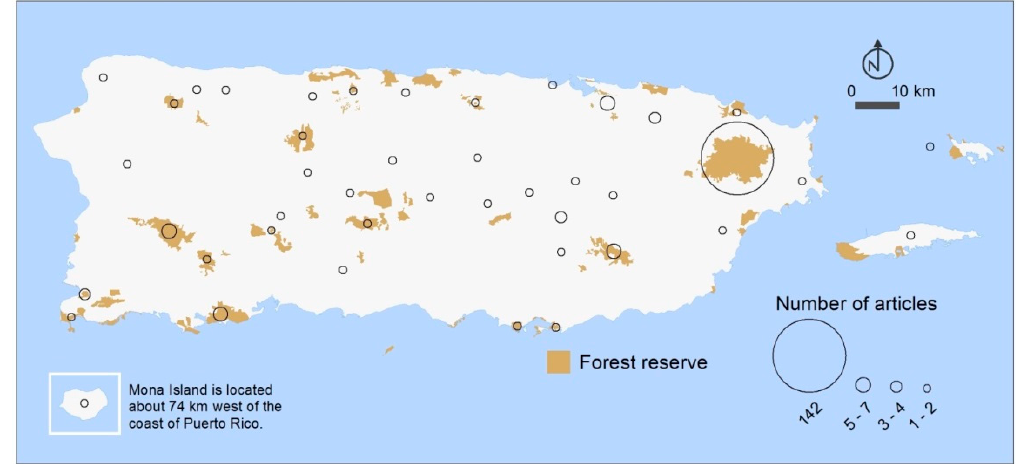
Figure 5. Location of study sites with number of articles published and geographic distribution of forest reserves.